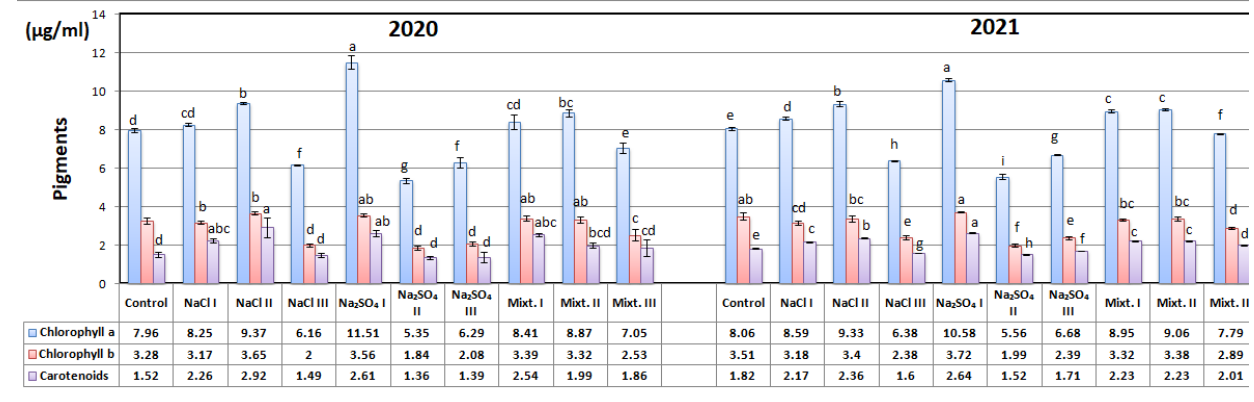
Figure 6. Concentrations of chlorophyll pigments in N. cataria L. studied variants with significant differences at 0.001 level indicated with letters.